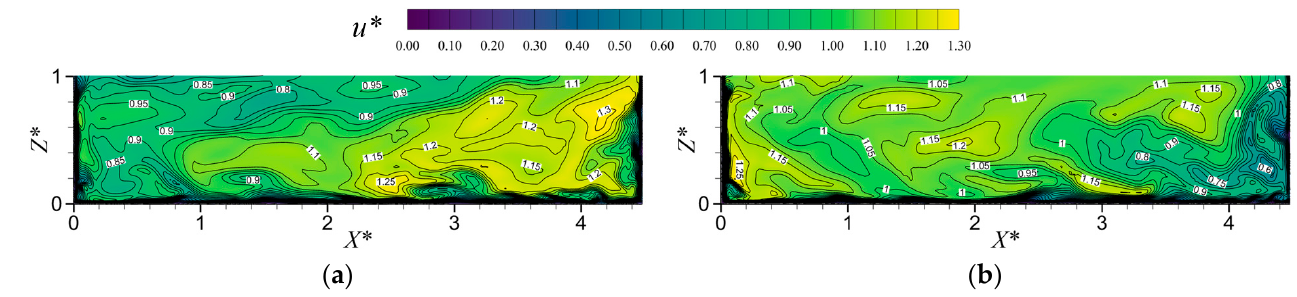
Figure 14. The normalized instantaneous streamwise velocity u* . ( a ) Section #04 in Case S1–S10; ( b ) and Section #07 in Case S1–S10.